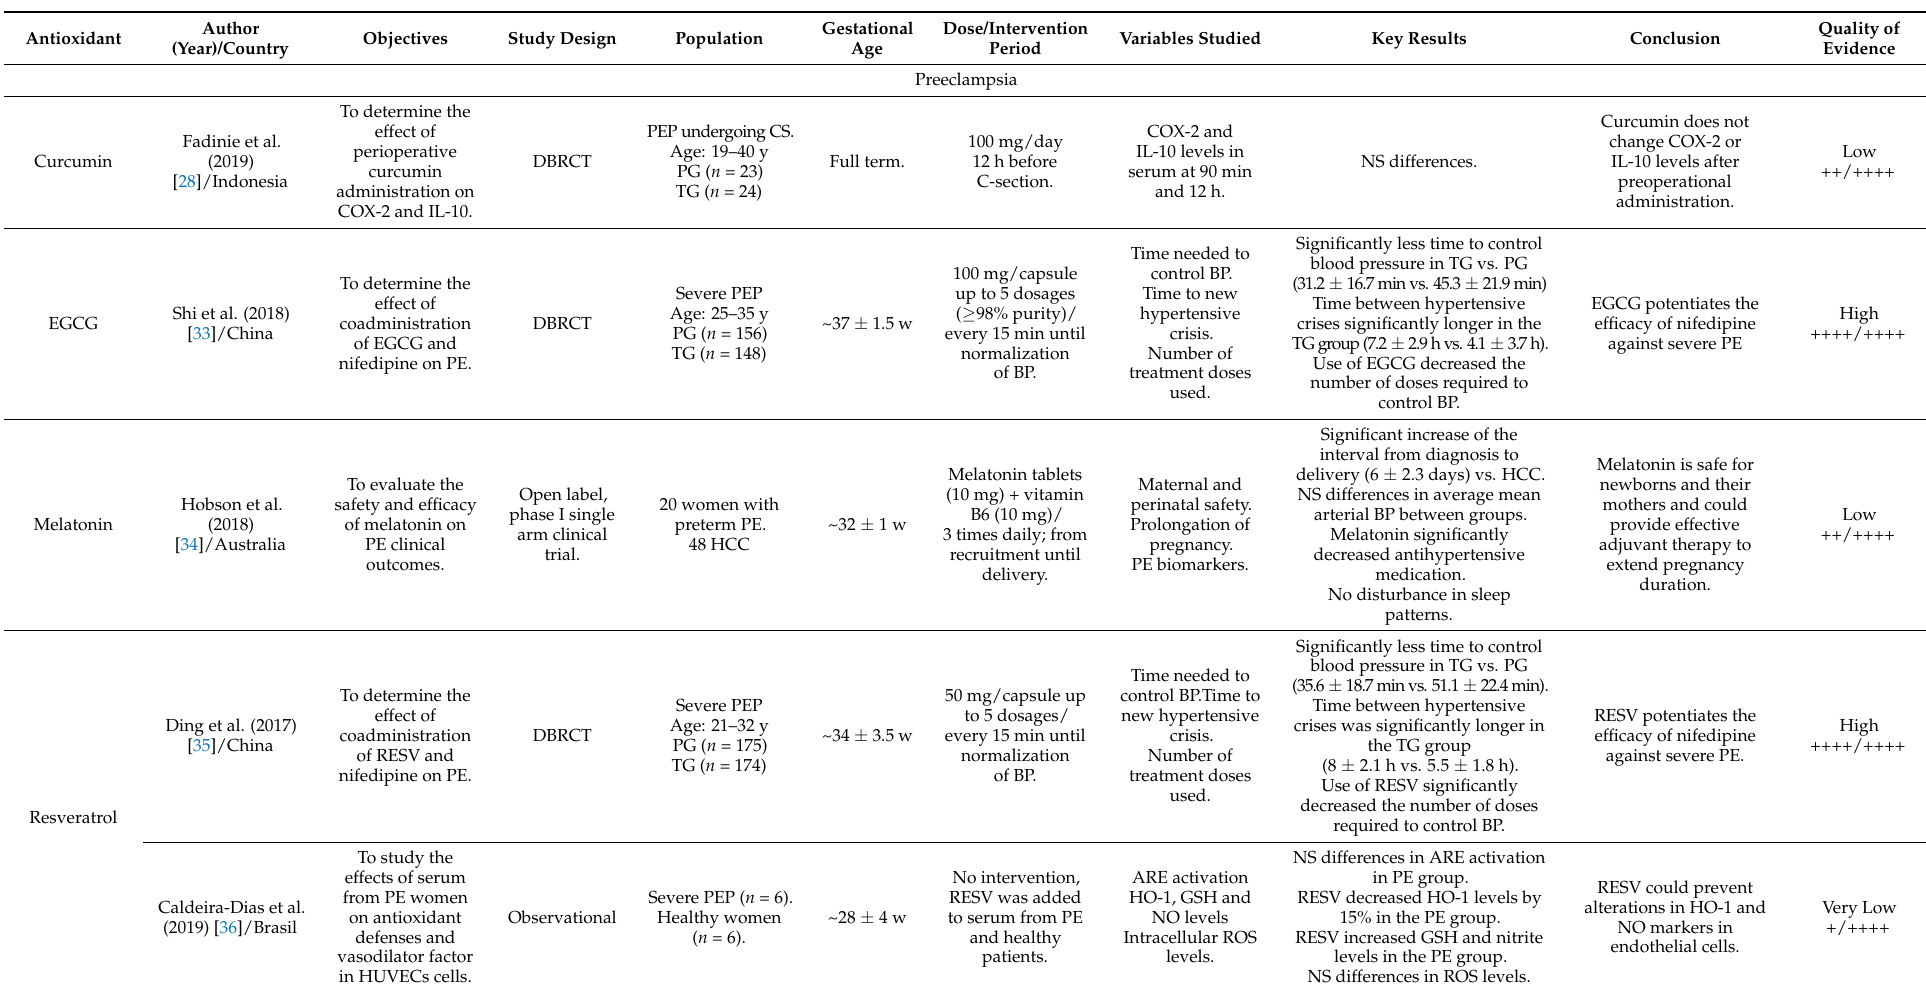
Table 1. Antioxidants used in the treatment of preeclampsia and fetal growth